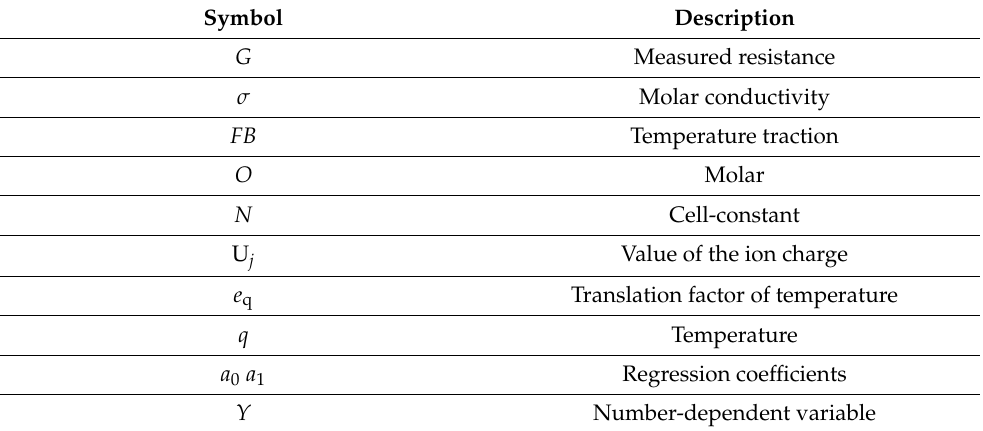
Table 1. Symbols and descriptions.